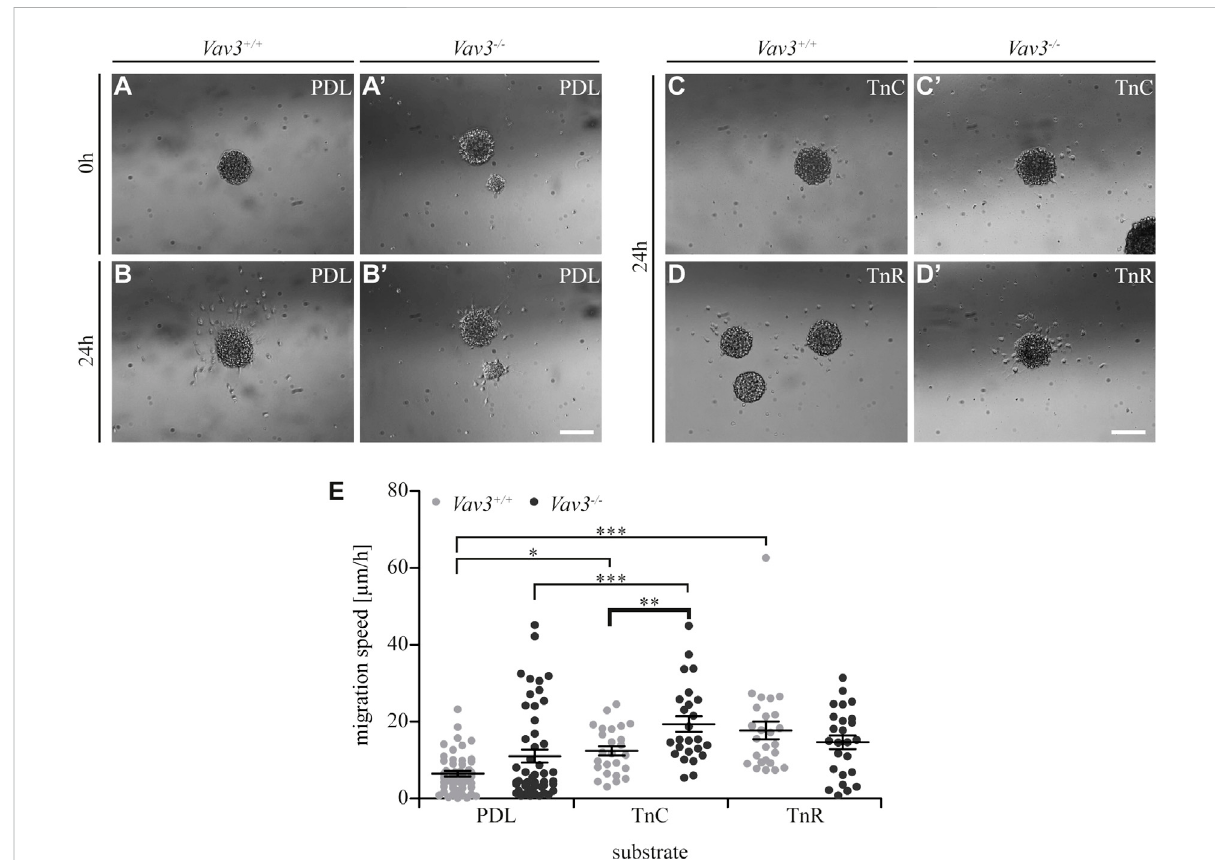
FIGURE 4 Migration speed of OPCs from oligospheres on PDL and tenascins. (A + A 9 ) Plated Vav3-expressing ( Vav3 +/+ ) and Vav3-de fi cient ( Vav3 − / − ) oligospheresonPDLsubstrate(control)attimepoint0 h. (B+B 9 ) PlatedoligospheresofeithergenotypeonPDLafter24 hofmigrationtime. (C+C 9 ) Oligospheresof eithergenotypeontenascin-C (TnC)substrate after 24 hofmigration. (D+D 9 ) Oligospheres ofbothgenotypes plated ontenascin- R (TnR) after 24 h of migration. (E) The quanti fi cation of migration speed [in µm/h]revealed not only signi fi cantly increased migration velocities on tenascins compared to PDL, but also a signi fi cant, Vav3-dependent effect on TnC: Vav3 − / − OPCs migrated signi fi cantly faster than Vav3 +/+ OPCs. Dataareexpressedasmean±SEM.Singlevaluesaredepictedasdatapoints.ANOVAwasperformedanddependingonnormaldistributionofvalues, BonferroniposttestorKruskal – WallisandDunn ’ sposttestfollowed(*** p ≤ 0.001;**0.01 ≥ p ≥ 0.001;* p ≤ 0.05).PDL: N =10, n =50;tenascins: N = 5, n = 25. Scale: 200